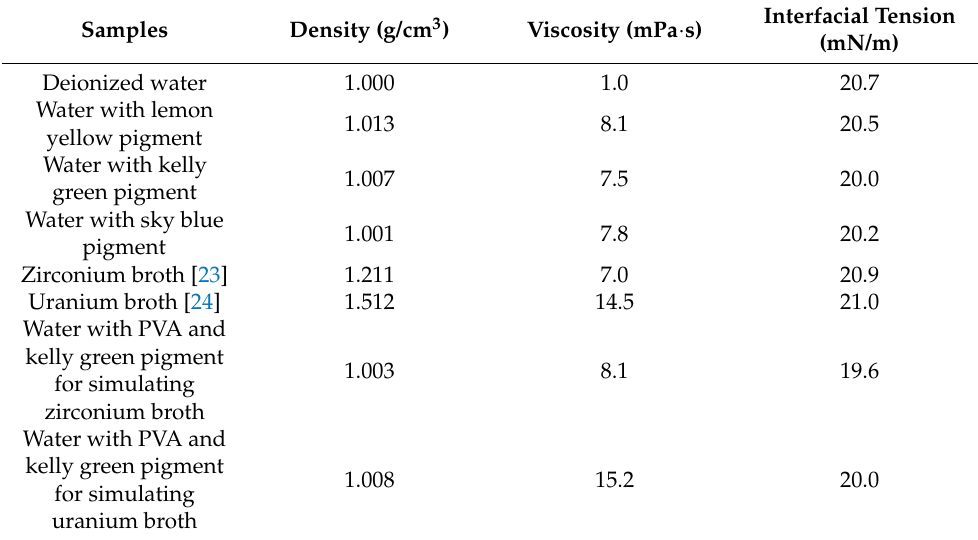
Table 1. The density, viscosity, and interfacial tension of different aqueous phases.